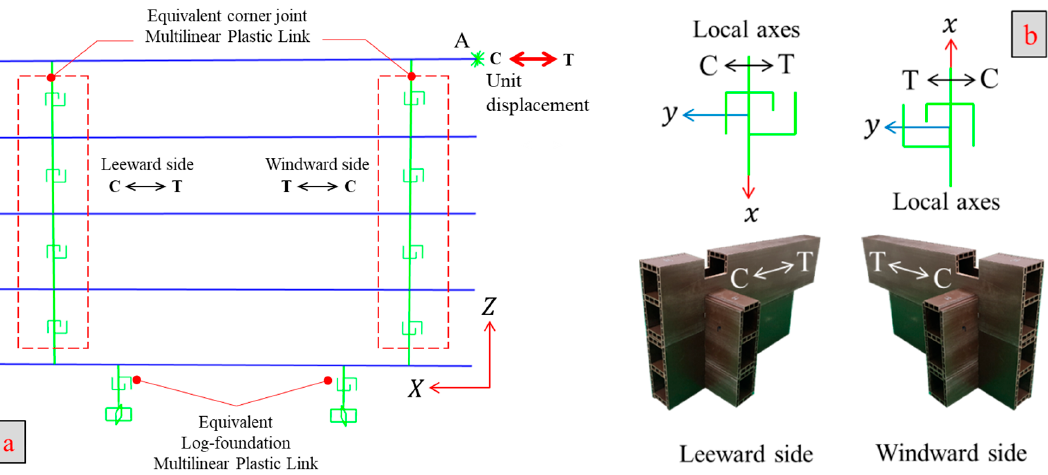
Figure 10. Finite element modeling schematic for WPVC composite log-wall: ( a ) Overall view; ( b ) Details of corner joints on leeward and windward sides.